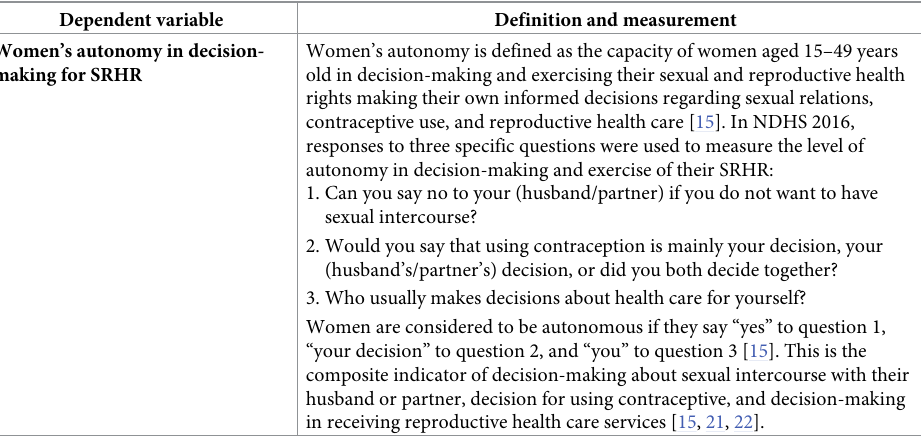
Table 2. Definition and measurement of the dependent